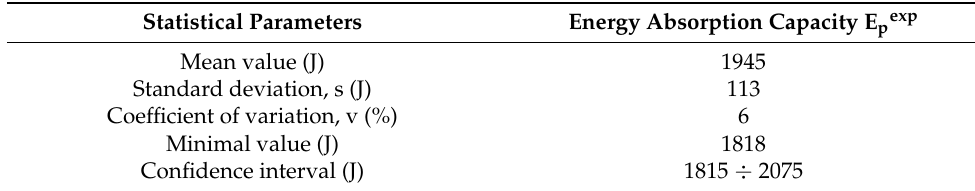
Table 3. Statistical parameters of the energy absorption capacity E pexp of the fiber composite used in the study.